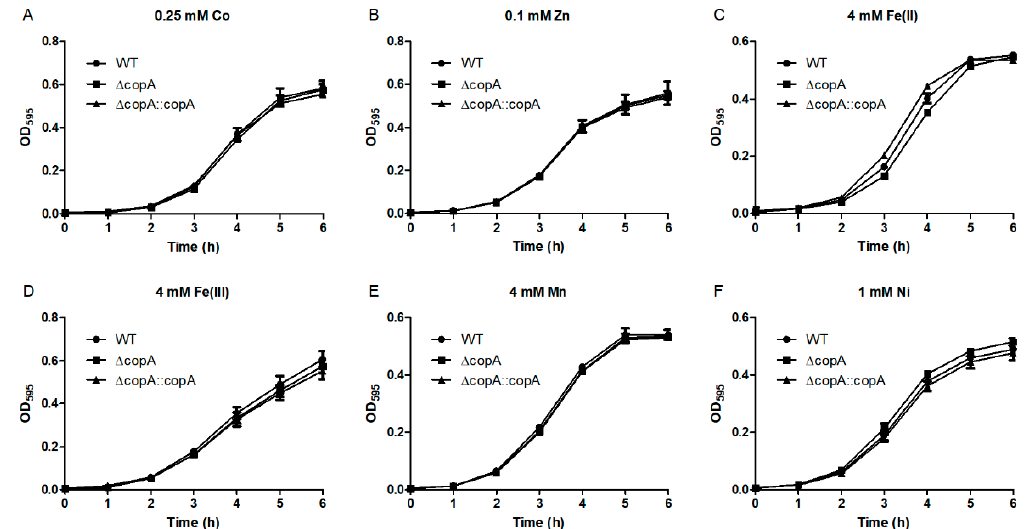
Figure 7. Growth curves of the WT, ∆ copA , and ∆ copA :: copA strains in the presence of various metals. 0.25 mM Co ( A ); 0.1 mM Zn ( B ); 4 mM Fe(II) ( C ); 4 mM Fe(III) ( D ); 4 mM Mn ( E ); 1 mM Ni ( F ).